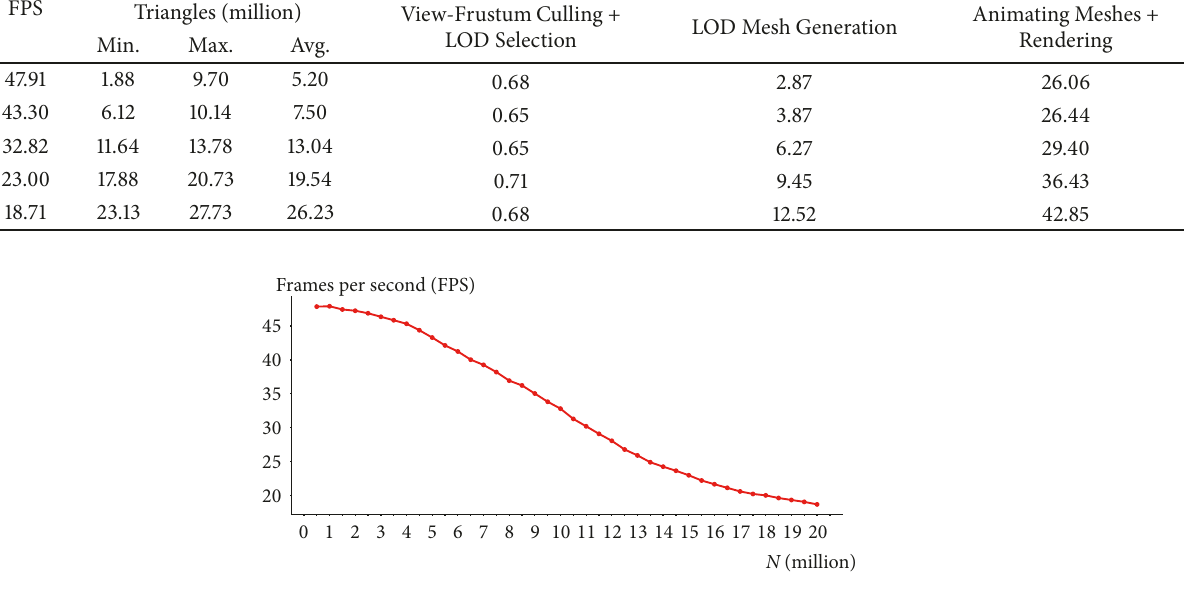
Figure 6: The change of FPS over different values of 𝑁 by using our approach. The FPS is averaged over the total of 1,000